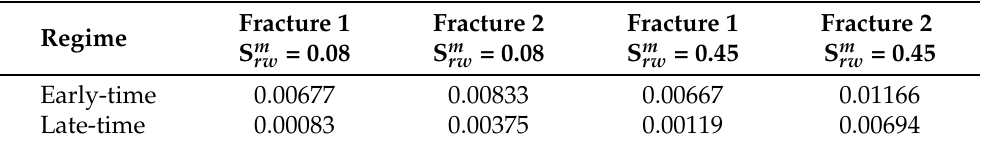
Table 5. Average wetting front velocity (m/s) in the fractures in the model TUFF2D, high precipitation rate (case